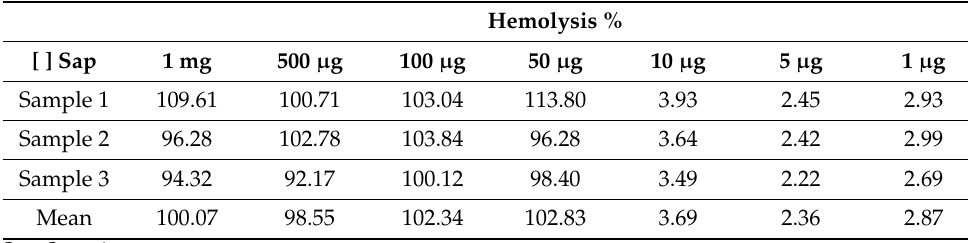
Table 1. Hemolytic activity of different concentrations of Quillaja saponaria extract.